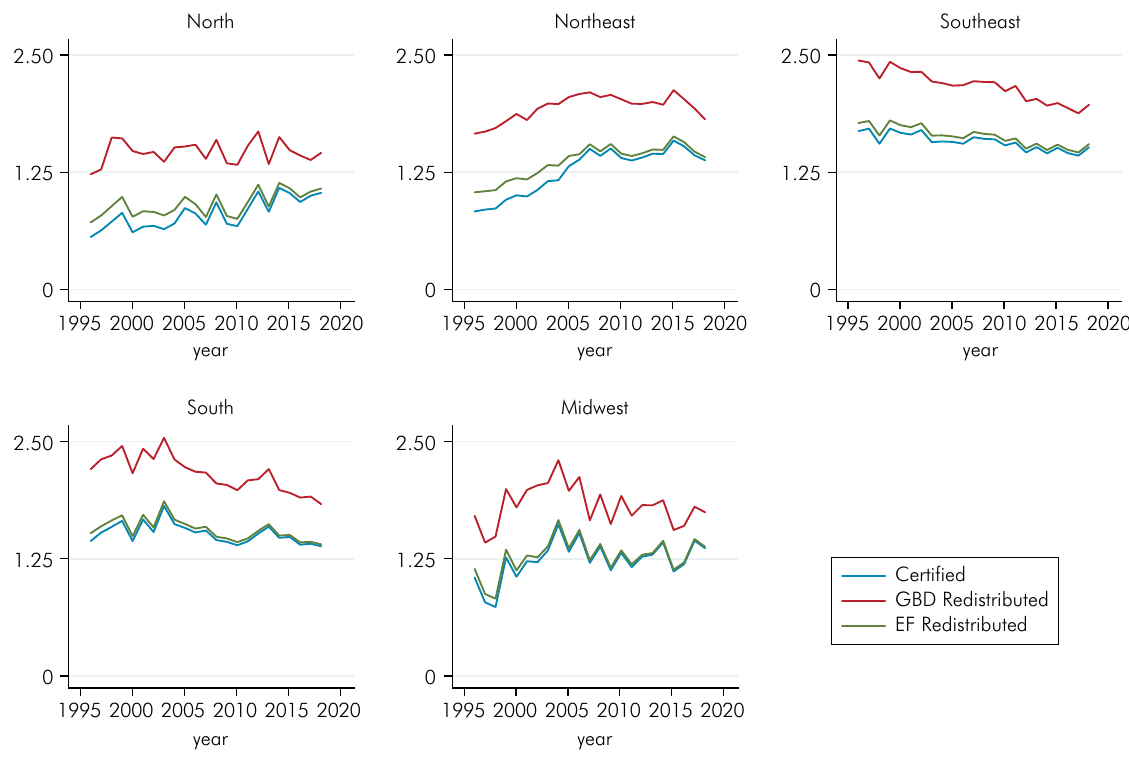
Figure 1. Oral cancer mortality, Brazil, 1996-2018. Certified and redistributed death rates by macro-region, both sexes, per 100,000